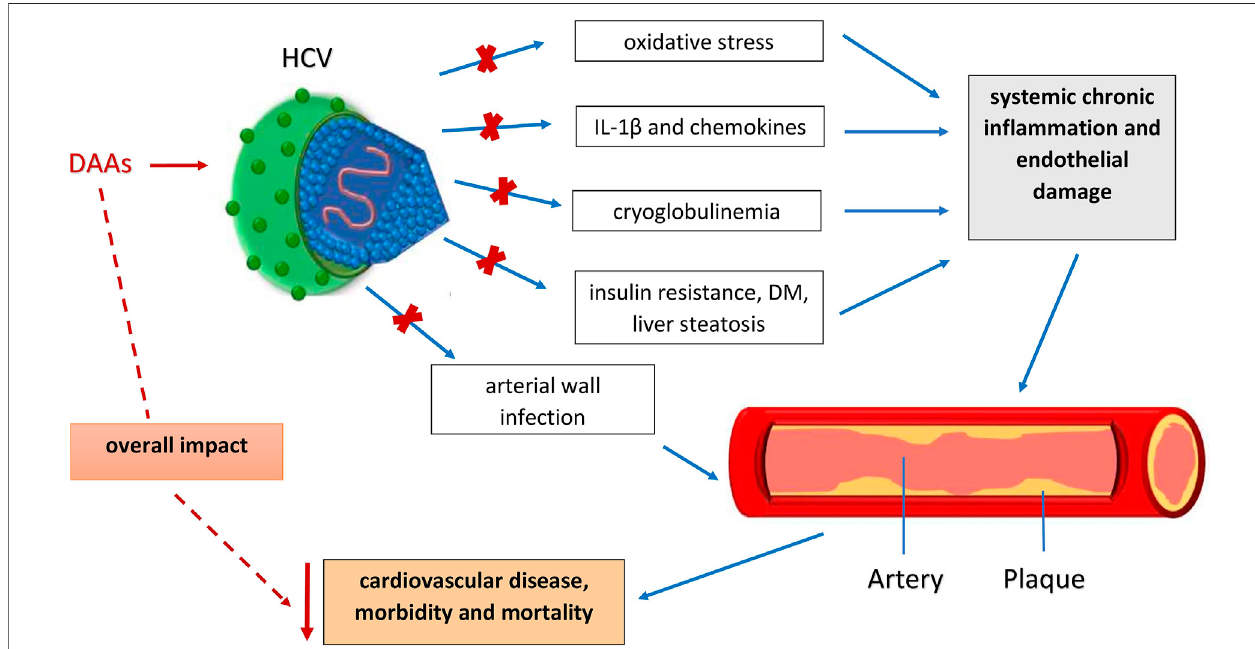
FIGURE1| In fl uence ofdifferentfactors responsiblefordevelopmentofatherosclerosis and CVDinHCV infected patientsand HCV eradication byDAA drugsand positive effects on cardiovascular outcomes. DAA - Direct-acting antiviral agents; HCV - Hepatitis C virus; IL-1 β - Interleukin-1 β .